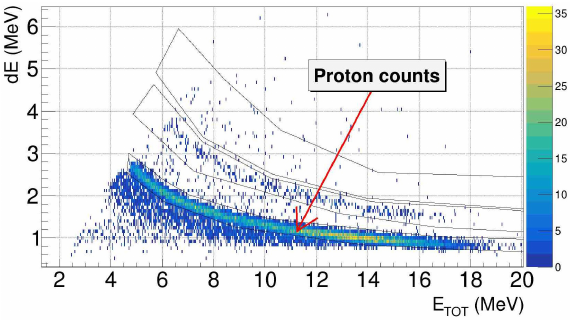
Figure 3. Particle type separation for PRT data.